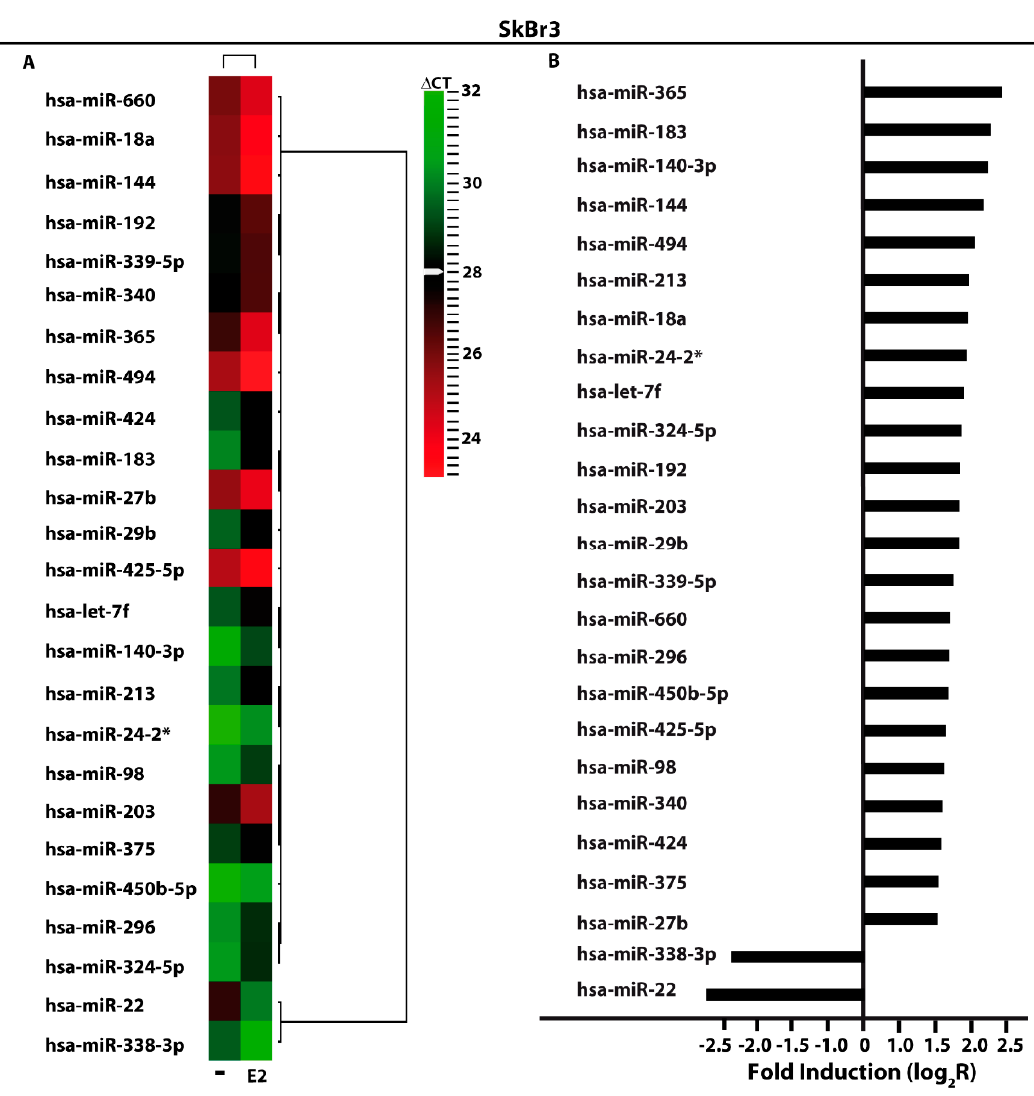
Figure 1. E2-modulated miRNAs expression in SkBr3 breast cancer cells. ( A ) Heat Map representation of E2-modulated miRNAs in SkBr3 cancer cells treated with 100 nM E2 for 4 h and analyzed by TaqMan Low-Density Array Human miRNA. Row represents a miRNA and column represents the treatment used. Each column is illustrated according to a color scale from green (low expression) to red (high expression). The distance measured is Euclidean Distance and the clustering method is complete linkage. Dendrograms of clustering analysis for miRNAs and samples are displayed on the top and right, respectively. ( B ) Up- and down-regulated miRNAs in SkBr3 breast cancer cells upon E2 stimulation. The values are indicated as log2 fold change (R) calculated respect to vehicle (-).